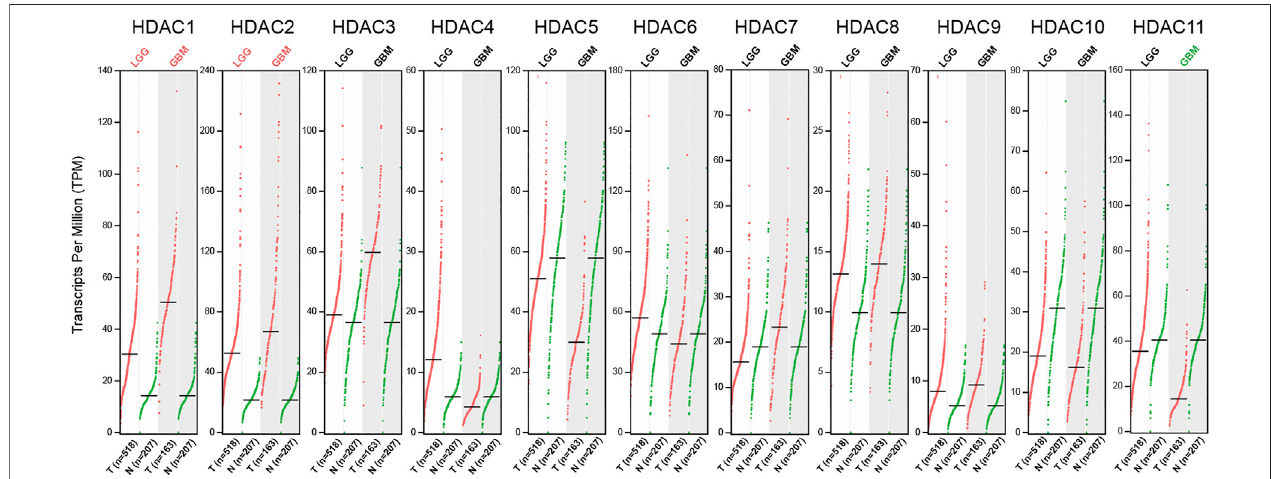
FIGURE 2 | RNA-seq data of HDAC family in LGG and GBM accessed from GEPIA. The Scatter plots showed expression comparisons of the HDAC family betweenthetumorandthenormalgroups.Thestatisticallysigni fi